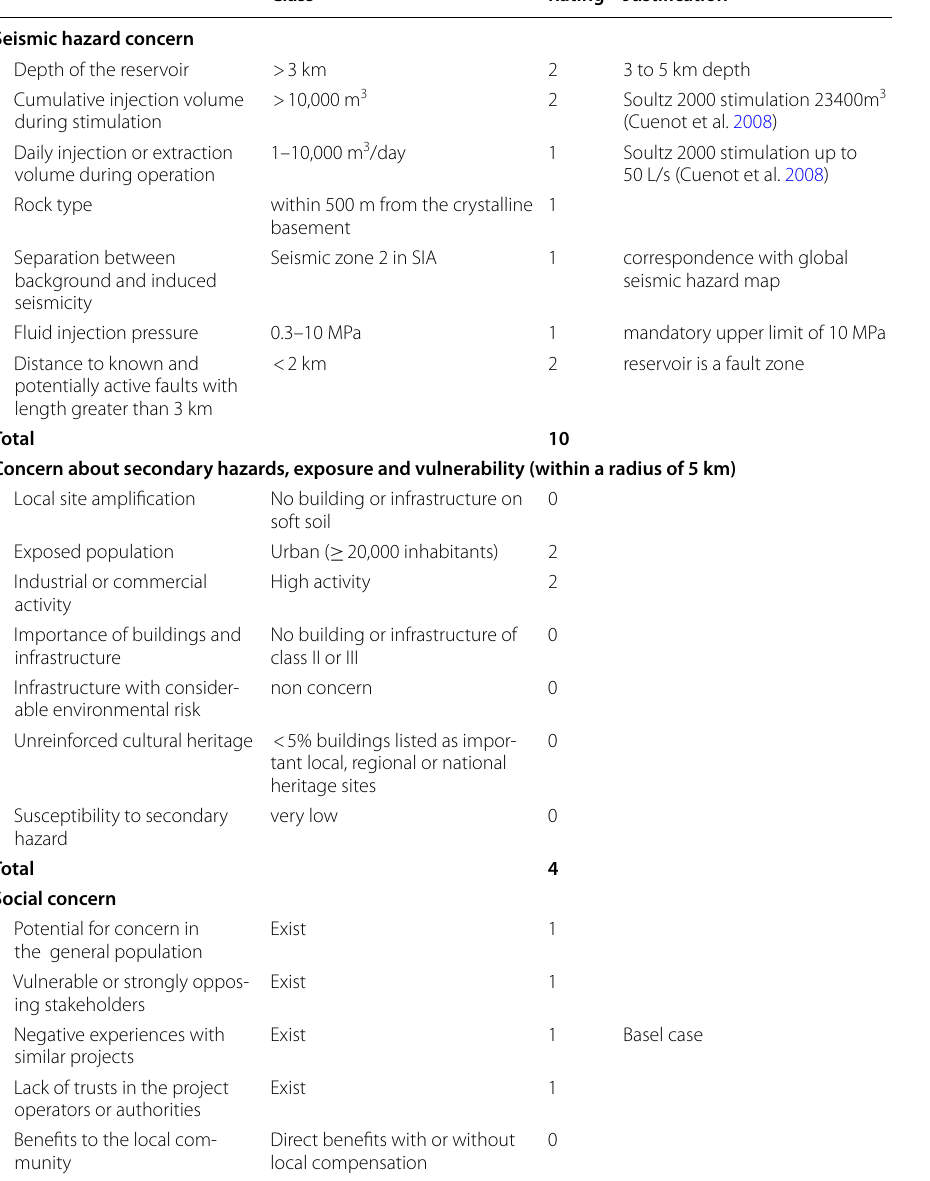
Table 2 GRID analysis applied to a URG project. For each indicator its evaluation is shown along with the corresponding score and its justification when necessary, based on representative